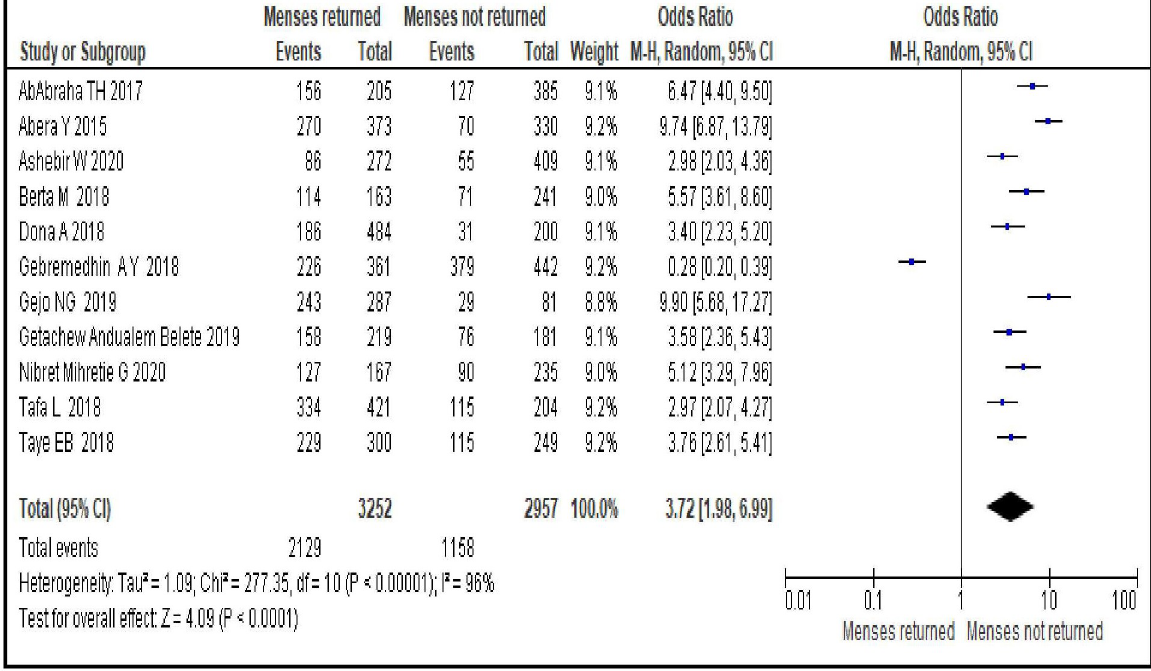
Fig 5. Association between menses return after birth and modern contraceptive uptake during postpartum period, 2021.